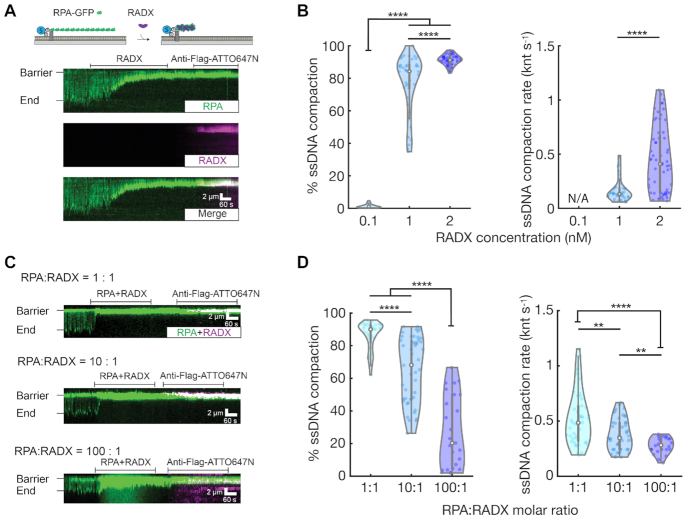
RADX condenses RPA-coated ssDNA. (A) Illustration (top) and a representative kymograph of 2 nM RADX condensing RPA-GFP-coated ssDNA. RPA-GFP was injected into the flowcell before adding RADX. (B) Quantification of RADX-induced RPA–ssDNA compaction. At least 22 ssDNA molecules were analyzed for each condition. ns, P> 0.05, *P< 0.05, **P< 0.01, ***P< 0.001, ****P< 0.0001. (C) Kymographs of ssDNA compaction in the presence of 1:1, 10:1 and 100:1 molar ratios of RPA-GFP and RADX (2:2, 20:2 and 200:2 nM RPA-GFP:RADX). RPA–GFP was injected into the flowcell before adding a mixture of RPA-GFP and RADX. Injecting 200 nM RPA–GFP generates a strong background green fluorescence signal until the proteins exit the flowcell (bottom panel). (D) Quantification of RADX-induced ssDNA compaction at different RPA to RADX molar ratios shown in (C). At least 25 ssDNA molecules were analyzed for each condition.